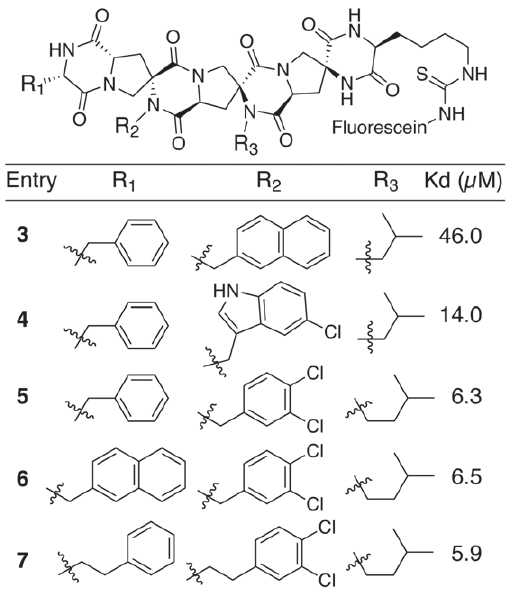
Figure 3. The structures of spiroligomers, which explored the use of different functional groups as side-chains on a fixed backbone (all centers have ‘‘ S ’’ stereochemistry).